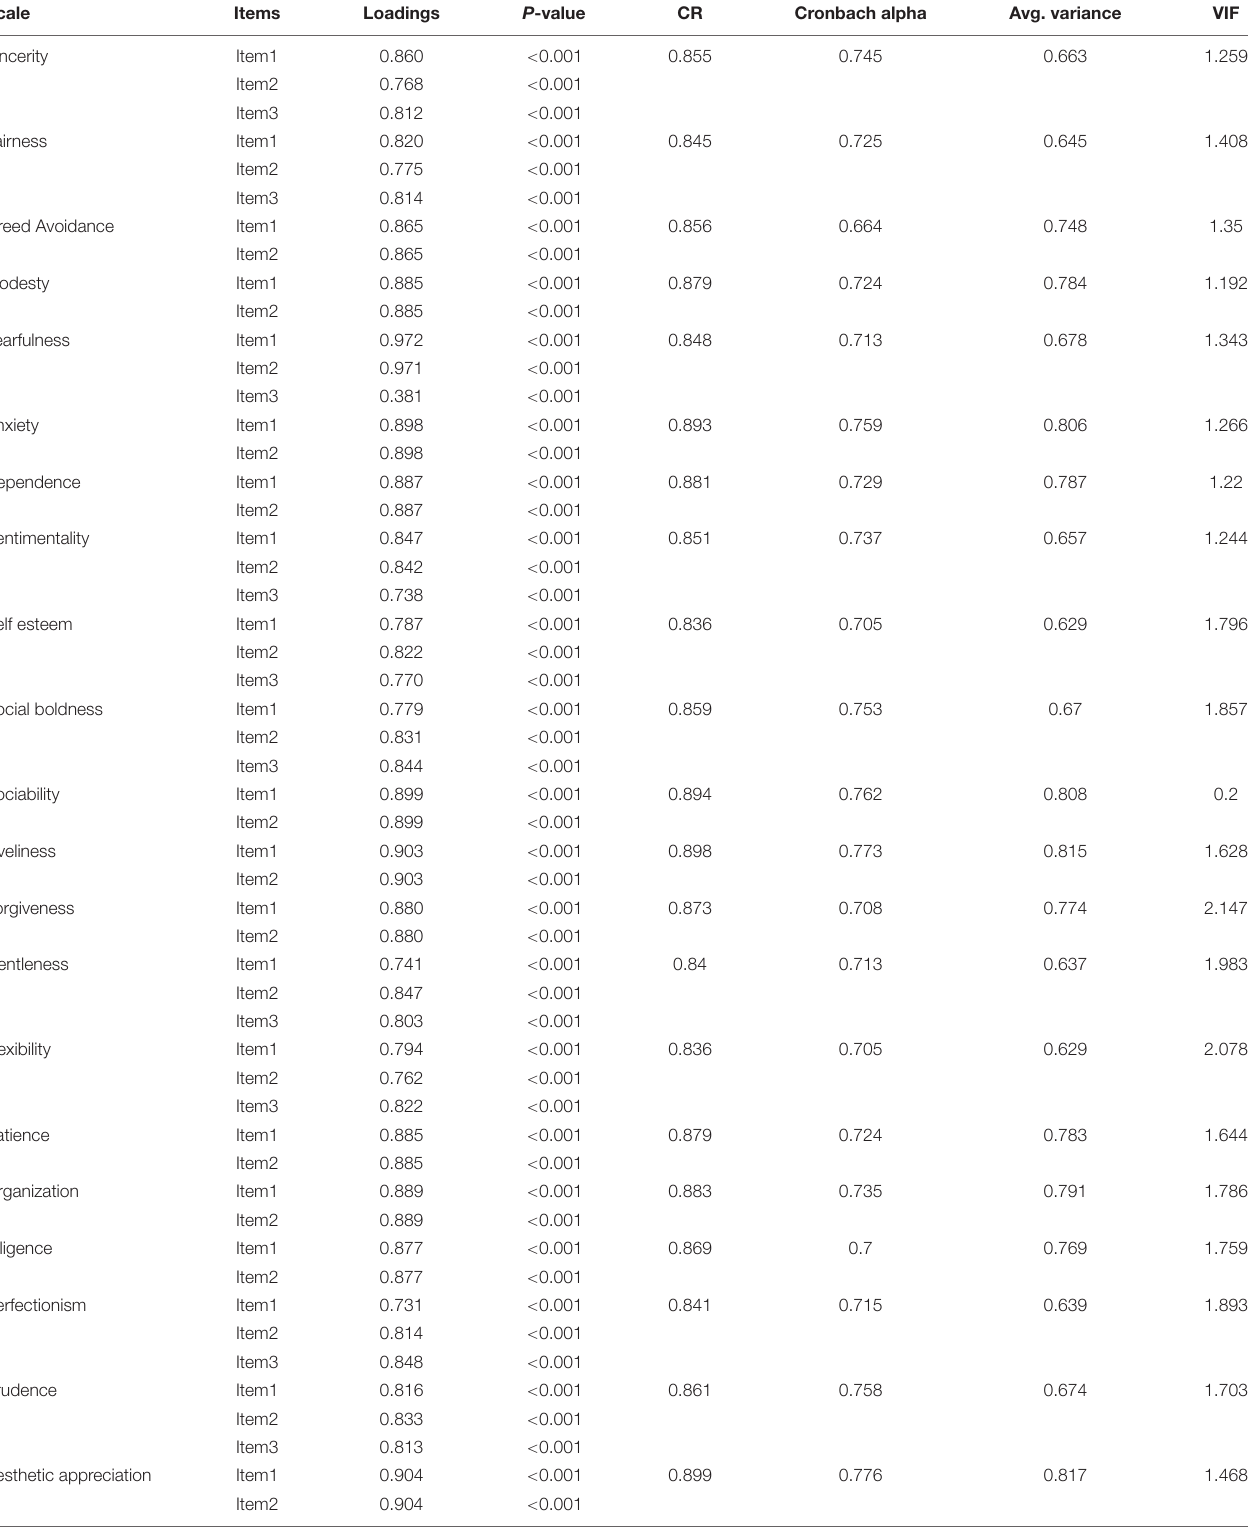
TABLE 2 | Assessment of measurement